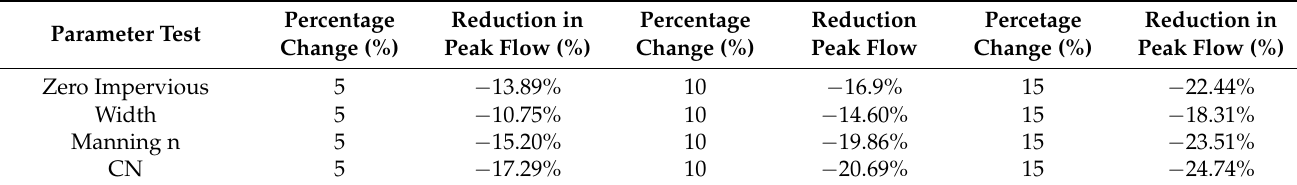
Table 5. Sensitivity analysis of SWMM parameters on peak